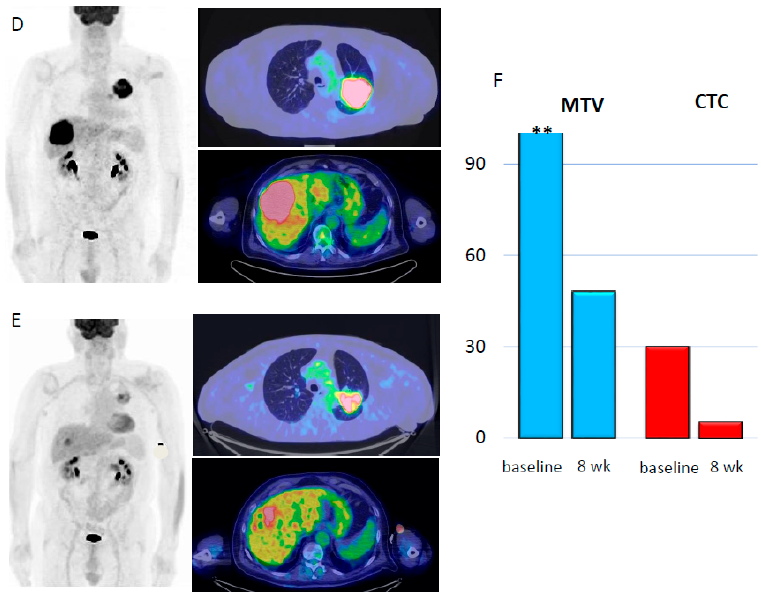
Figure 3. Two cases of progression ( A – C ) and response ( D – F ) to ICI according to metabolic parameters and CTC evaluation. ( A ) Maximum intensity projection (MIP) with two axial slices of liver and celiac node metastases at baseline. ( B ) Increase of tumor burden and appearance of further metastatic sites within the liver and in the abdominal nodes at the first restaging. ( C ) Bar graph representation of MTV (blue bars) between the baseline (49.4 mL) and the first restaging (97.2 mL). Likewise, CTC count (red bars) increased from 30 to 60. ( C ) MIP with two large lesions within the lung and liver at baseline. ( D ) 18F-fluorodeoxyglucose positron emission tomography/computed tomography (18F-FDG PET/CT) at 8 weeks, which demonstrated a decrease of overall tumor burden. ( F ) Bar graph representation of MTV (blue bars) at baseline (256.5 mL) and at 8 weeks (48 mL). Likewise CTC count (red bars) decreased from 30 to 5, * MTV= 97.2 mL; ** MTV= 256.5 mL. Table 2. Uni- and multivariate Cox proportional hazard regression analyses for the prediction of PFS and OS.